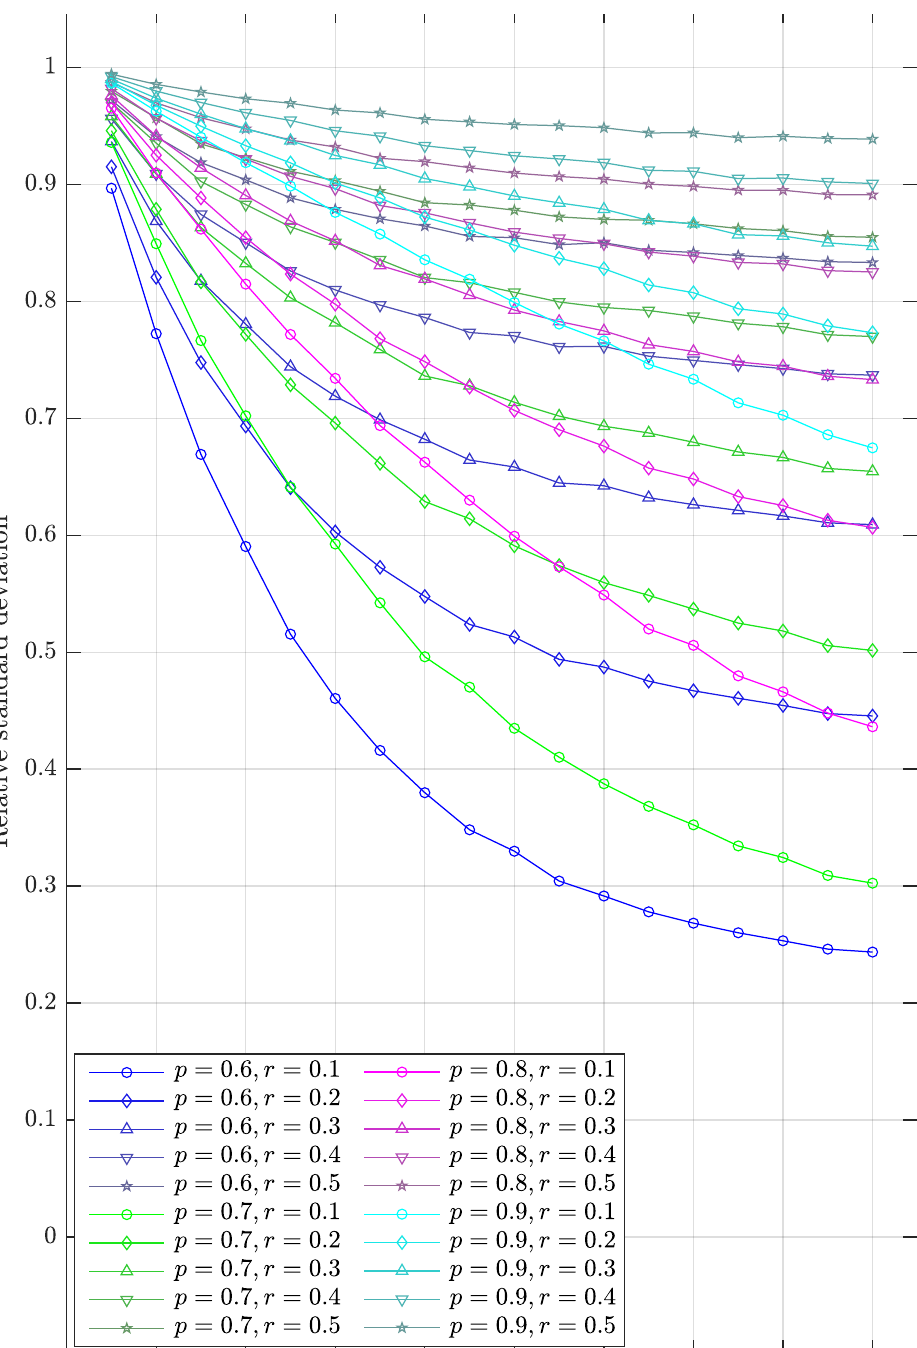
Figure 2. Relative standard deviation (heteroskedastic rms over homoskedastic rms) of the fitted slope k for all 20 combinations of p and r in the range 3 ≤ n ≤